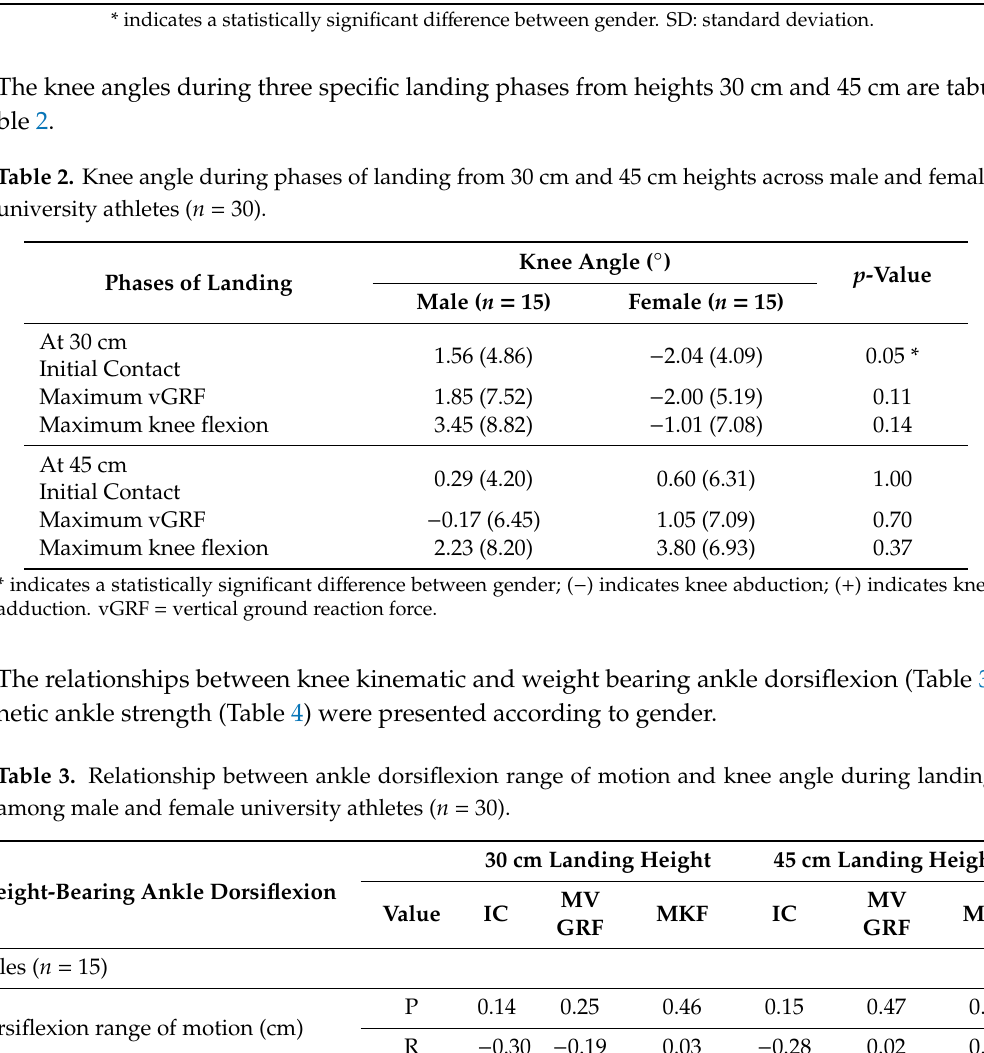
Dorsiflexion range of motion (cm) Females ( n = 15)